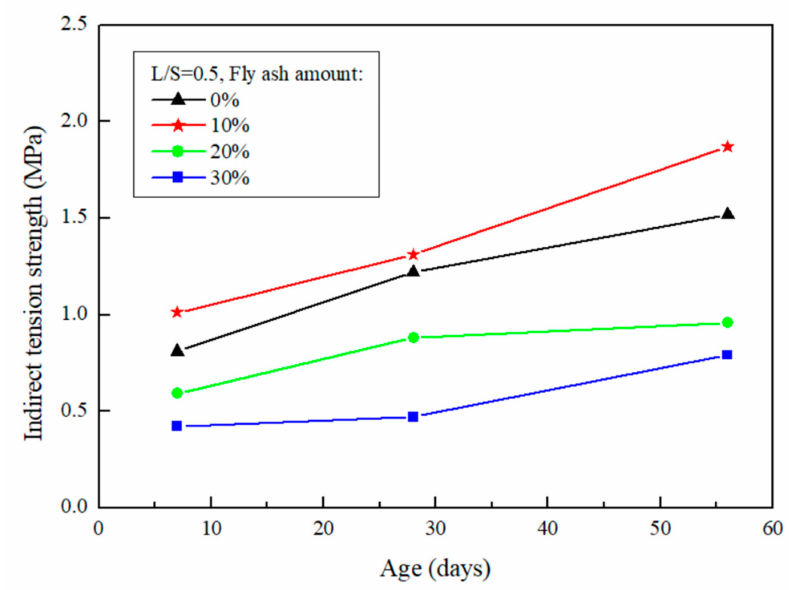
Figure 9. The e ff ect of di ff erent fly-ash amount on FGG split tensile test when L / S =